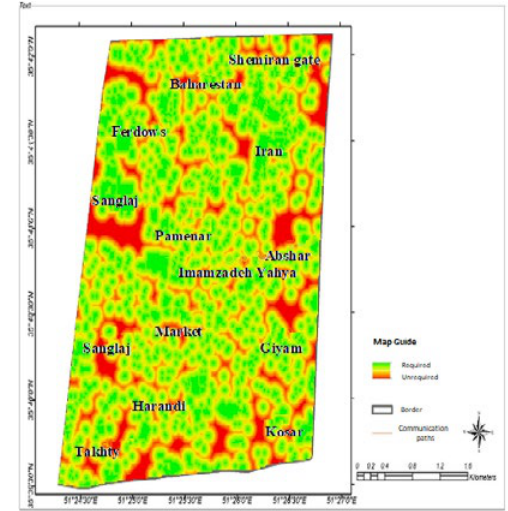
Fig. 17: Raster distance layer from administrative ‐ cultural centers Fig. 18: Fuzzy distance layer from administrative ‐ cultural centers